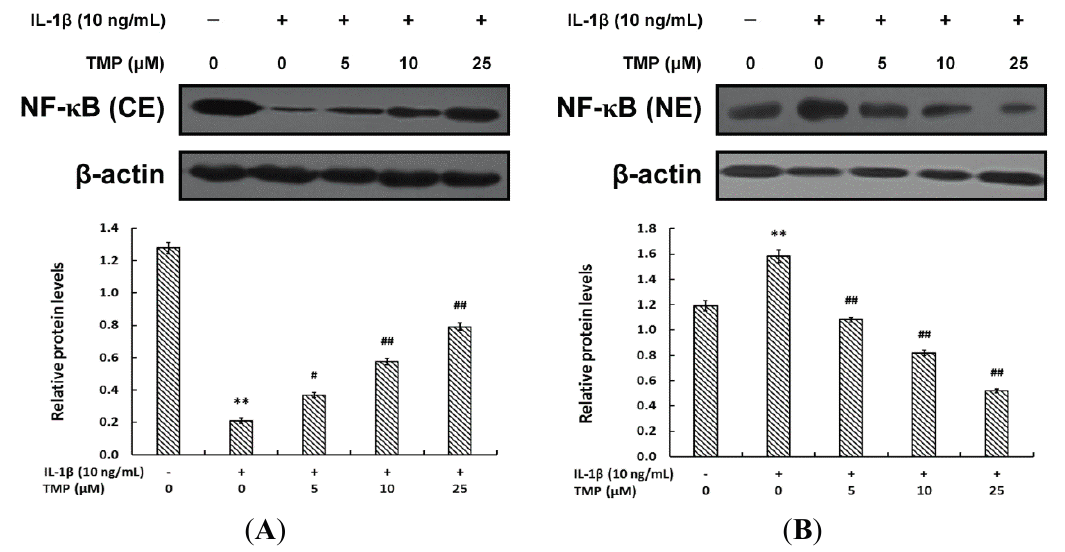
Figure 4. Effect of TMP on IL-1 β -induced nuclear translocation in TR-iBRB2 cells. After treatment of indicated drugs, nuclear and cytoplasmic fractions were analyzed for the expression of NF- κ B p65 subunit by Western blot analysis. ( A ) Relative protein level of NF- κ B p65 subunit in cytoplasm of TR-iBRB2 cells; ( B ) Relative protein level of NF- κ B p65 submit in nucleus of TR-iBRB2 cells. All data were expressed as mean ± SD of three experiments and each experiment included triplicate repeats. ** p < 0.01 vs.